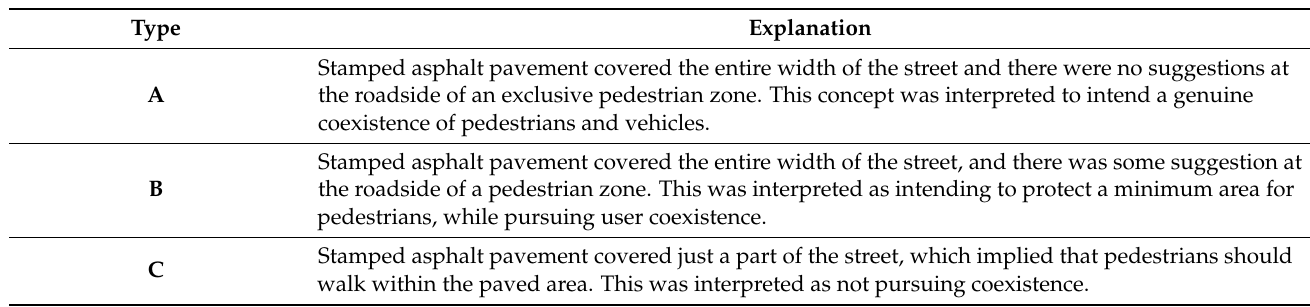
Table 1. The type of paving design by the extent of “visual separation (VS)”.